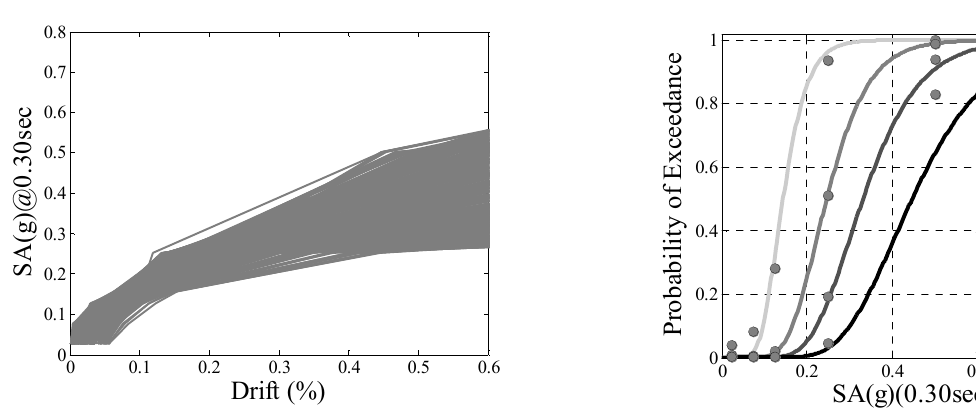
sa LS represents the median estimate of the distribution. The values of β and sa LS are also provided in Fig. 11. The func- tions can be employed in future applications for the dam- ageability assessment of considered DS masonry structures during earthquake induced ground